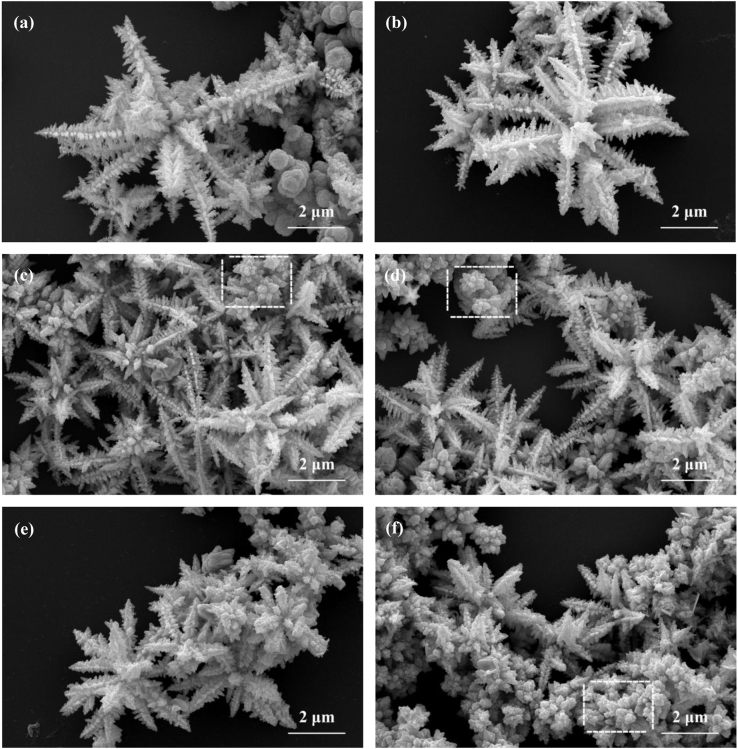
SEM images of pure CdS NFs (a) and NiS/CdS NFs HSNC prepared with 0.6 mmol NaH2PO2·H2O and different FMRs of Ni/Cd: (b) 0.4, (c) 0.6, (d) 0.8, (e) 1 and (f) 1.2, while the amount of Cd(NO3)2·4H2O was fixed at 1 mmol. The obtained pure CdS NFs were synthesized under the same condition as that for NiS/CdS NFs HSNCs but without Ni(CH3COO)2·4H2O and NaH2PO2·H2O (also see Table 1).